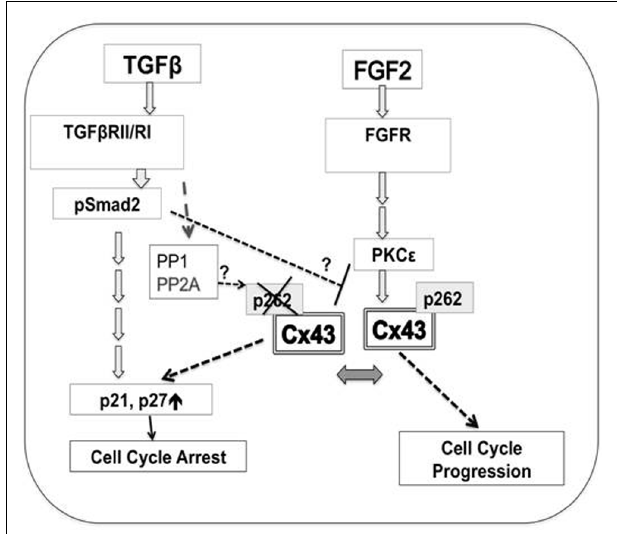
FIGURE 6 |A hypothetical model for the regulation of cardiomyocyte proliferation by Cx43 phosphorylation at S262. Mitogen (FGF-2)-triggered signaling includes activation of cognate receptor (FGFR, fibroblast growth factor receptors), downstream activation of PKC ε , followed by increased interaction between PKC ε and Cx43, and phosphorylation of Cx43 at S262.This phosphorylation event blocks the ability of Cx43 to act as a suppressor of DNA synthesis, and allows FGF-2 signaling to promote cell cycle progression. EarlyTGF β -triggered signaling includingTGF β RII/RI and Smad2/3 activation results in decreased levels of pS262-Cx43, allowing Cx43 to act as a growth suppressor.TGF β signaling may: activate phosphatases such as PP1, or PP2A, to affect Cx43 dephosphorylation; prevent the FGF-2-induced PKC ε activation, and/or prevent PKC ε /Cx43 interaction and thus Cx43 phosphorylation.These possibilities are indicated by question marks. Cx43-, as well as TGF β -mediated inhibition of cell proliferation is achieved via downstream activation of cell cycle inhibitors